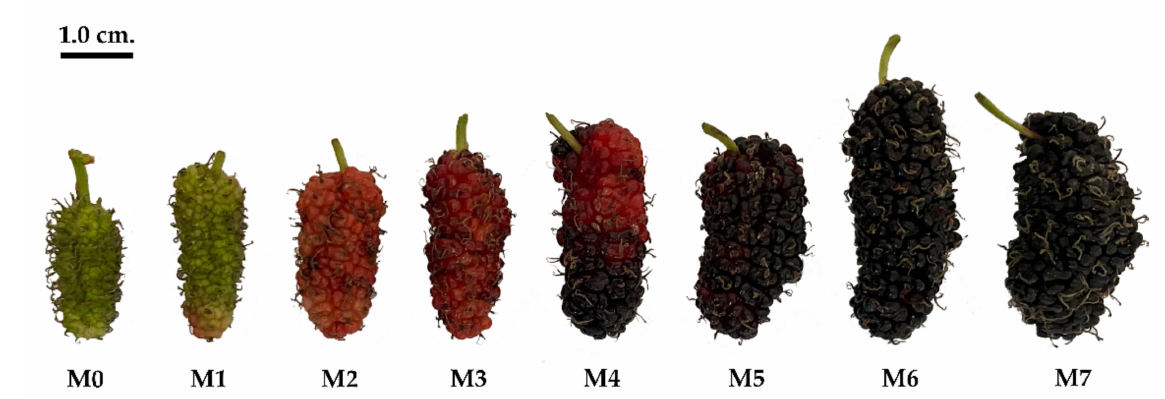
Figure 1. Mulberry fruit ( Morus alba L.) during